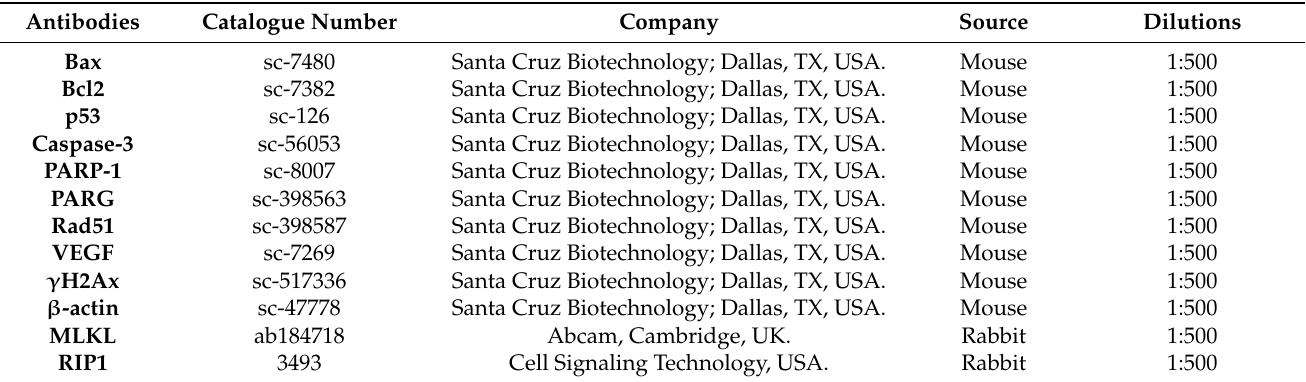
Table 2. Primary antibodies used for Western blot